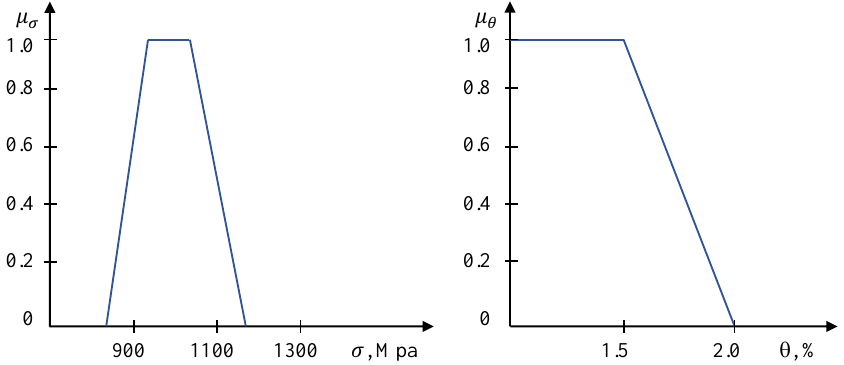
Figure 4. Membership functions of the most important quality